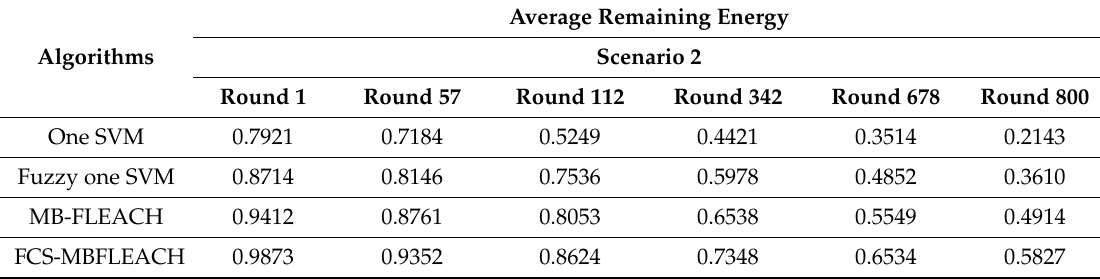
Table 3. Average remaining energy in di ff erent rounds for the second